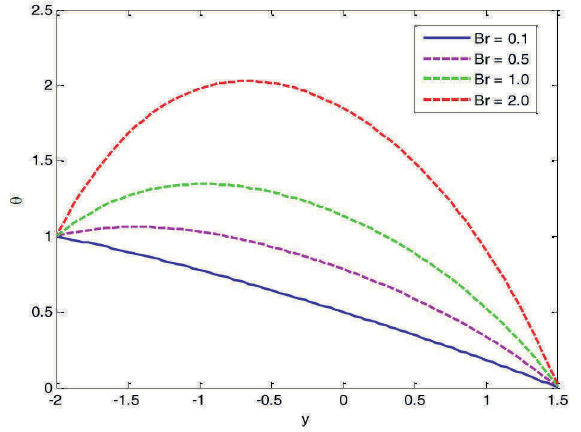
Fig. 12: Impact of Hall parameter m on temperature.